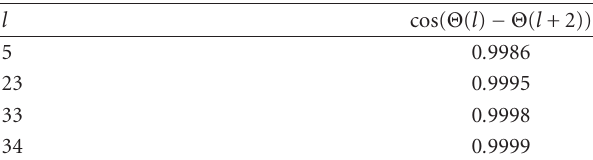
Table 4: Mean angle correlation of WMAP data in Ecliptic coordi-